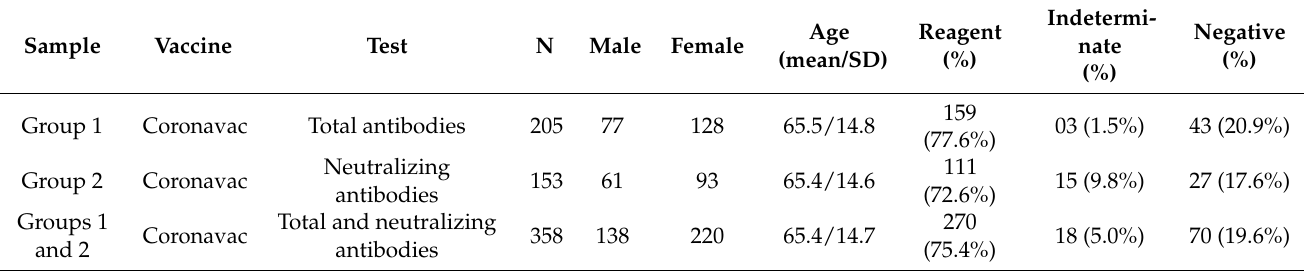
Table 1. Frequency of anti-SARS-CoV-2 total antibodies (S1 and S2) and anti-SARS-CoV-2 neutralizing antibodies (RBD-S1) after two doses of Coronavac in Belem,